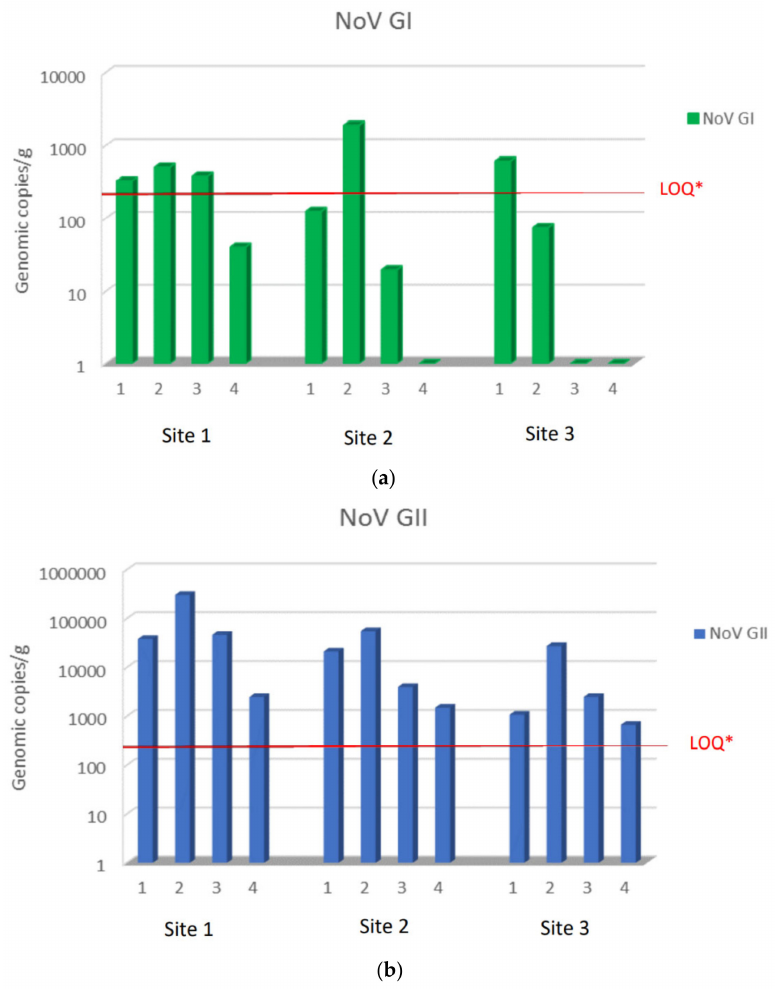
Figure 2. NoV RNA levels detected in oysters at Time 0 of the relay (T0) at site 1, site 2, and site 3: ( a ) NoV GI; ( b ) NoVGII. Values are expressed in genome copies/gram. * LOQ: 140 g.c./g for NoV GI and 130 g.c./g for NoV